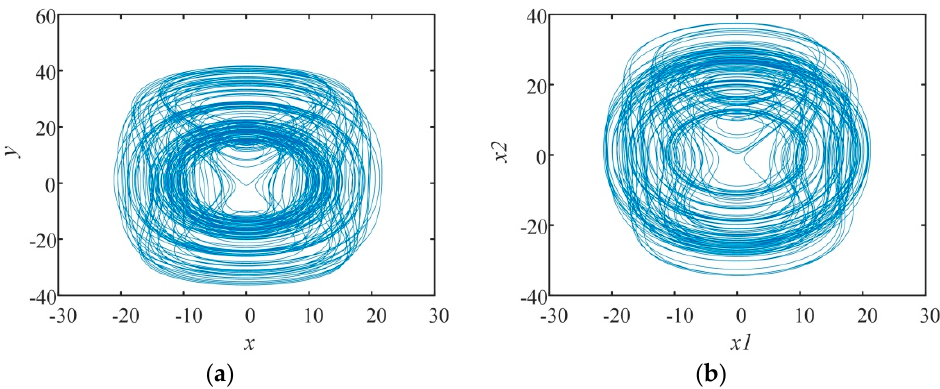
Figure 5. Phase diagram of chaotic attractor. ( a ) Phase diagram before ADM decomposition, ( b ) Phase diagram after ADM decomposition.